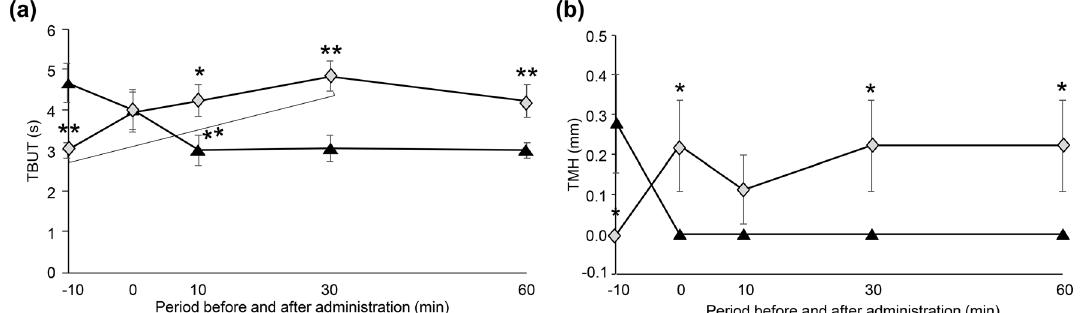
Figure 2. Changes in the tear film breakup time (TBUT) ( a ) and tear meniscus height (TMH) ( b ) over time. All results are expressed as the mean ± standard error. Significant differences from the control group are indicated by * p < 0.05 or ** p < 0.01 . Black triangle: control, grey diamond: SUPER H2 (molecular hydrogen; H 2